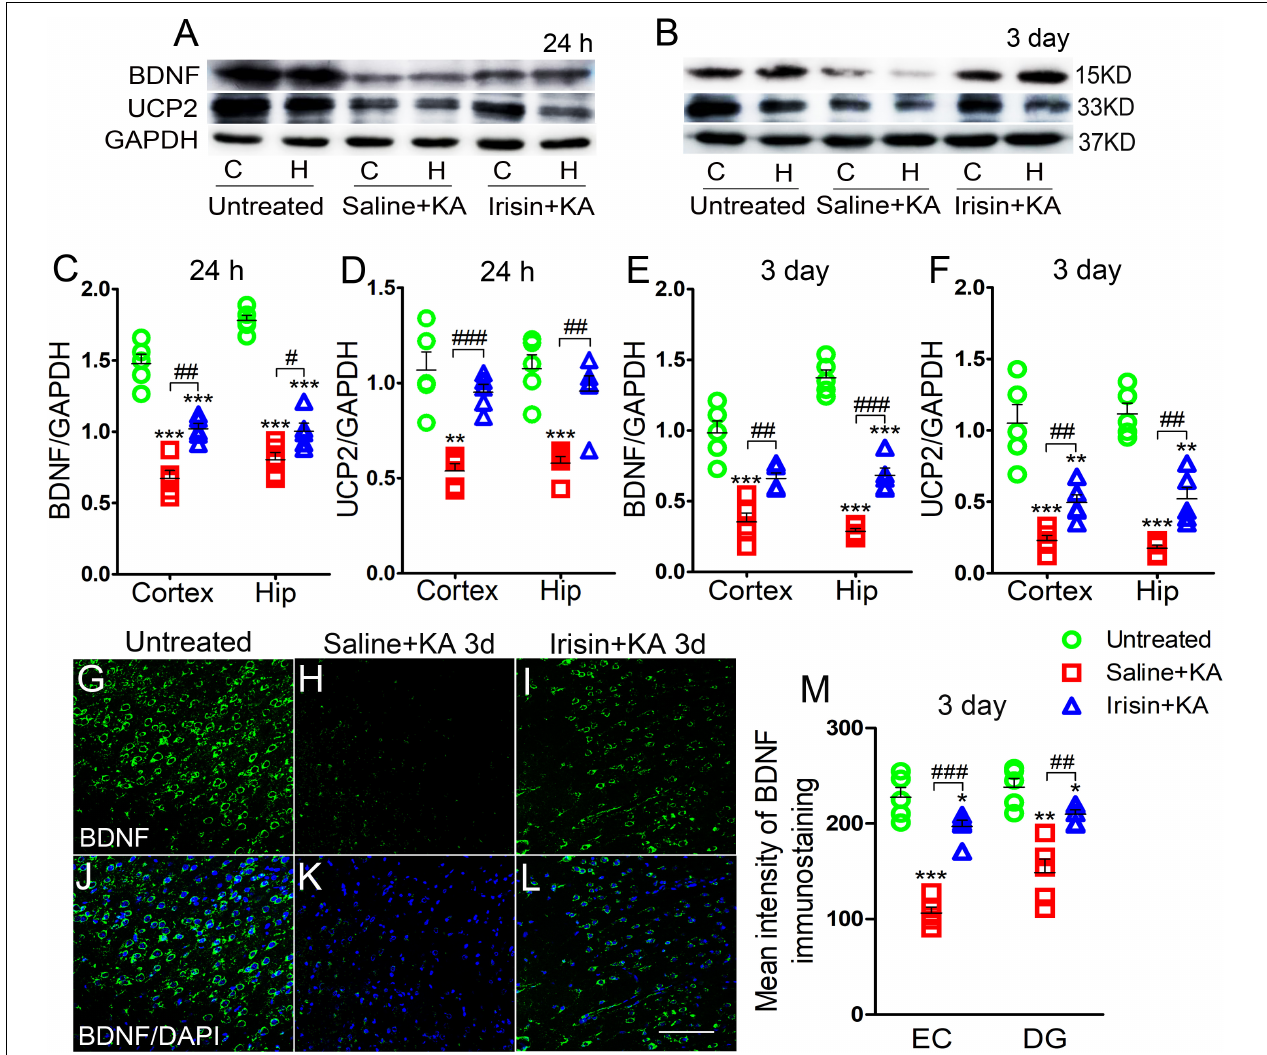
FIGURE 1 | Exogenous irisin treatment increased the expression of BDNF and UCP2 in rats with KA-induced SE. (A,B) The expression of BDNF and UCP2 were detected by western blotting after KA treatment ( n = 5 per group). (C–F) Normalized intensity of BDNF and UCP2 relative to GAPDH in the cortex and hippocampus. (G–M) The mean fluorescence intensity of BDNF immunostaining (green) in the left EC after exogenous irisin treatment ( n = 5 per group). DAPI, blue. Bar = 50 µ m. * P < 0.05, ** P < 0.01, and *** P < 0.001, compared with controls; # P < 0.05, ## P < 0.01, and ### P < 0.001 compared with each other (One-way ANOVA